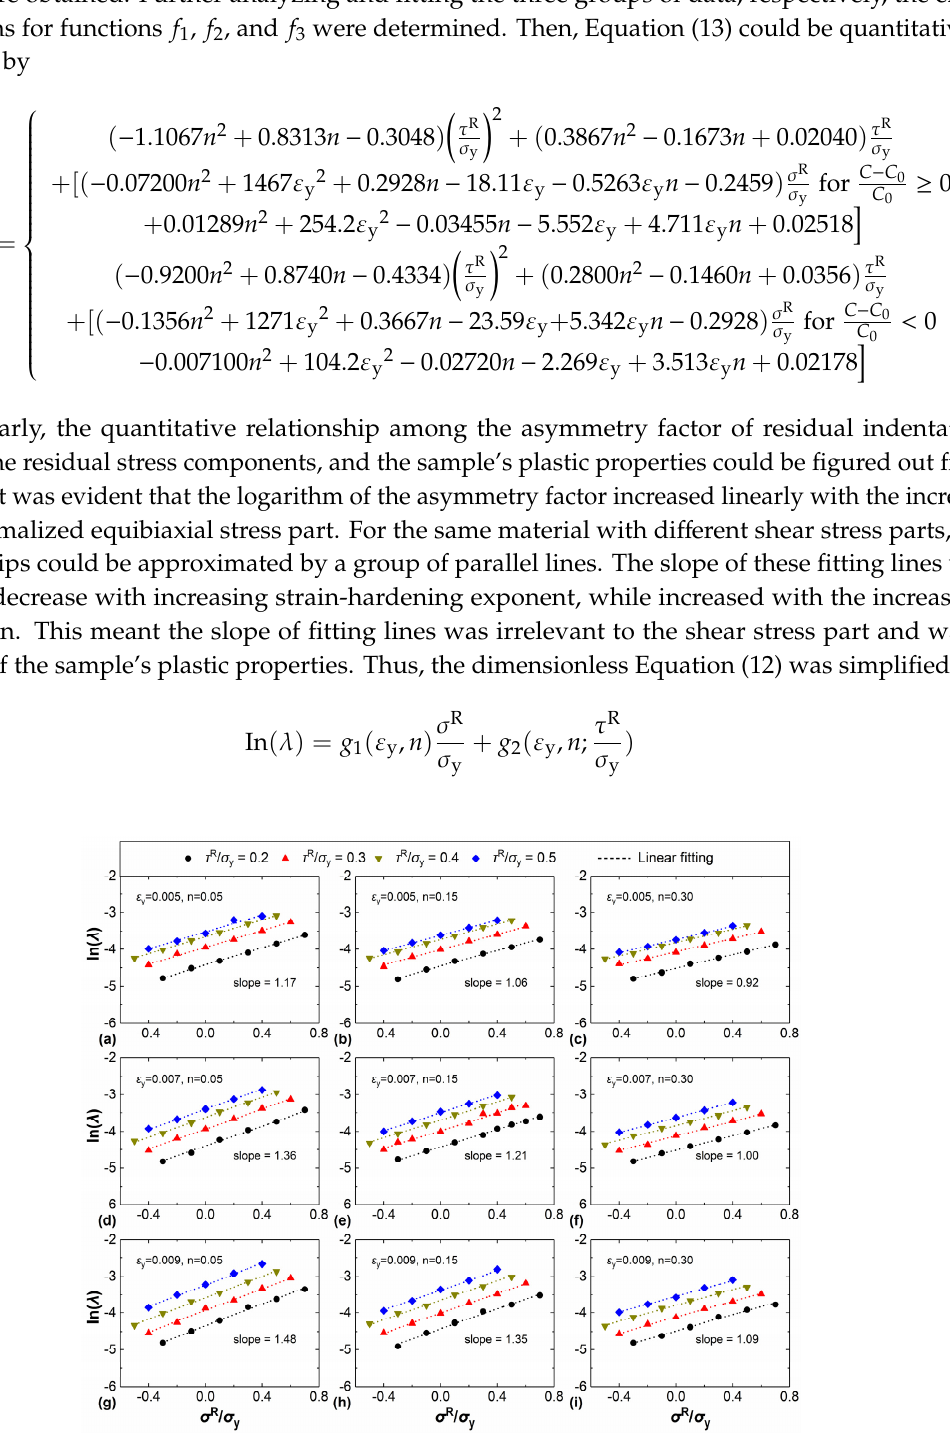
Figure 6. The variation of the asymmetry factor of residual indentation imprint with the normalized equibiaxial stress part for nine representative metals under various shear stress parts: ( a ) ε y = 0.005, n = 0.05, ( b ) ε y = 0.005, n = 0.15, ( c ) ε y = 0.005, n = 0.3, ( d ) ε y = 0.007, n = 0.05, ( e ) ε y = 0.007, n = 0.15, ( f ) ε y = 0.007, n = 0.3, ( g ) ε y = 0.009, n = 0.05, ( h ) ε y = 0.009, n = 0.15, ( i ) ε y = 0.009, n =